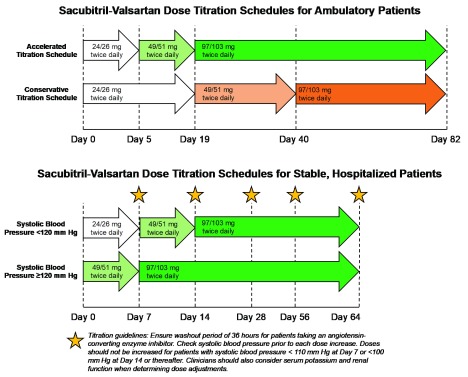
Titration schedules for ambulatory and hospitalized patients initiating sacubitril-valsartan.